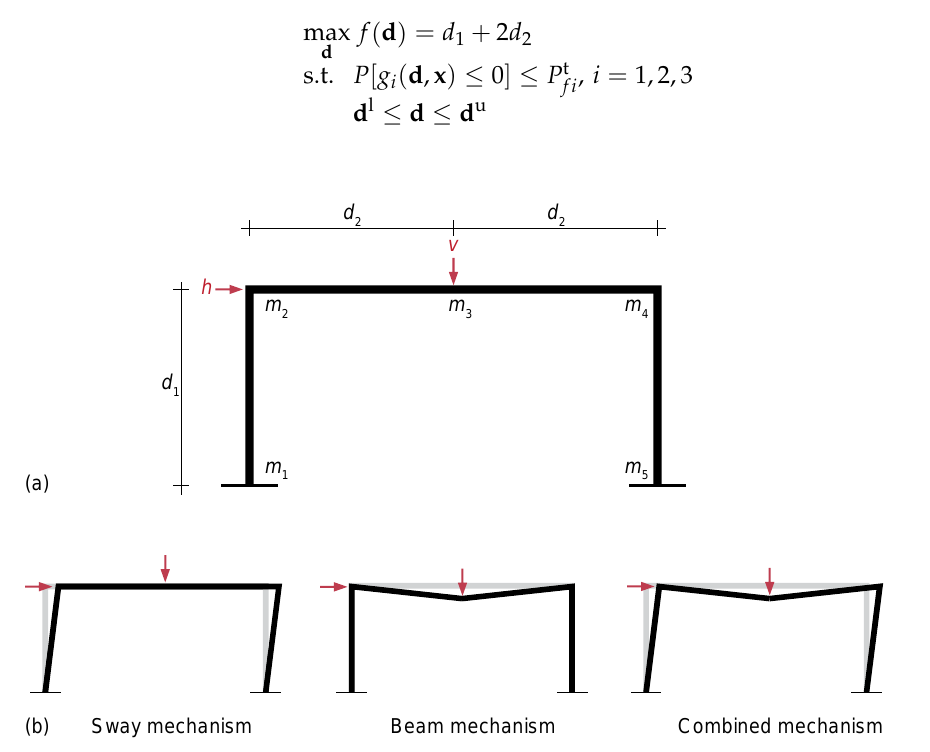
Figure 9. ( a ) Ductile frame structure and ( b ) failure mechanisms. Table 9. Description of the random variables for the ductile frame optimization problem. Random